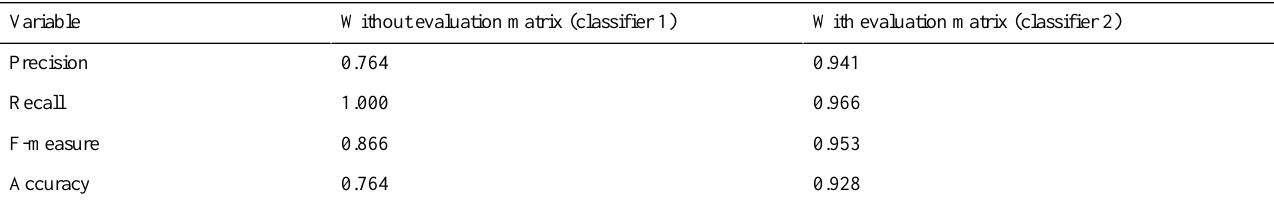
Table 1. Metrics comparing the performance of manual analysis (classifier 1) and the evaluation matrix (classifier 2) [26].